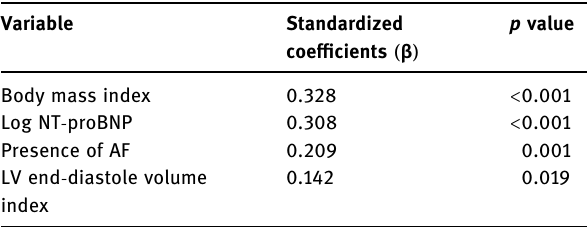
Table 4: Multivariable logistic regression analysis for prediction